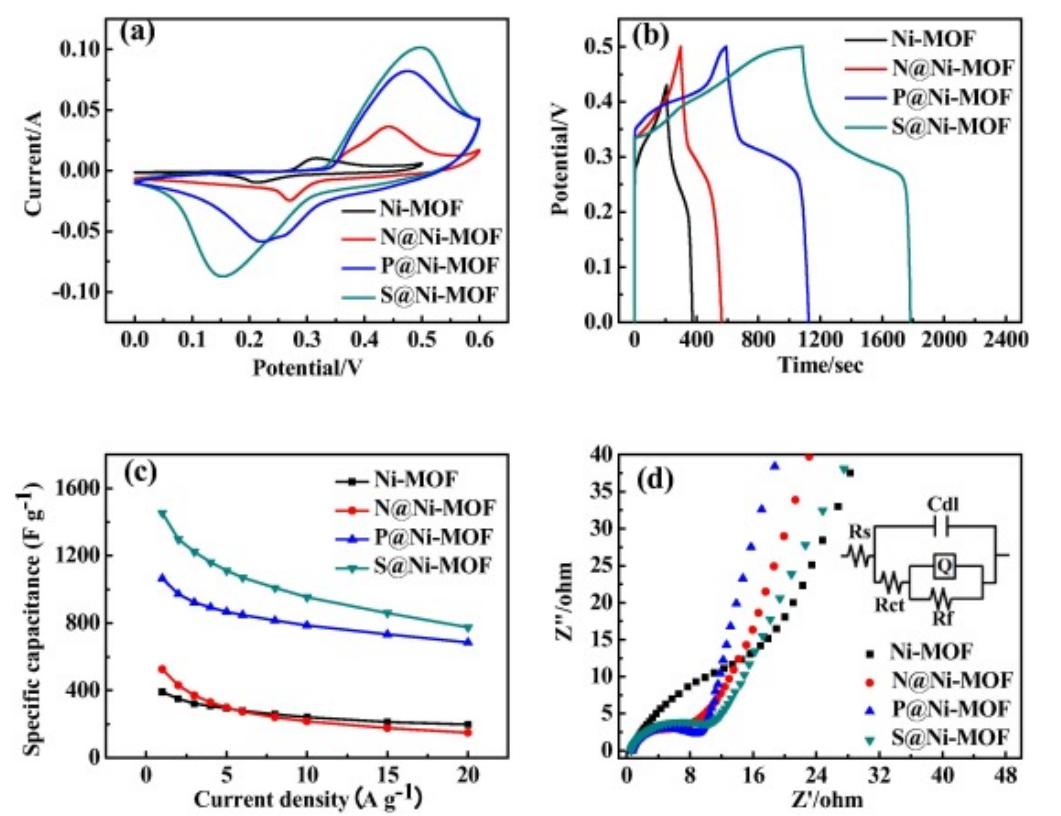
Figure 24. ( a ) CV curves of the four electrode materials measured at 30 mV s − 1 . ( b ) GCD curves of the four electrode materials measured at 1 A g − 1 . ( c ) The curves of the specific capacitance versus current density for four different materials. ( d ) Nyquist plots of the precursor and three composite electrode materials in 3M KOH in the frequency range of 100 kHz to 0.01 Hz. The inset is the equivalent circuit of S@Ni–MOF[104]. Reproduced with permission.